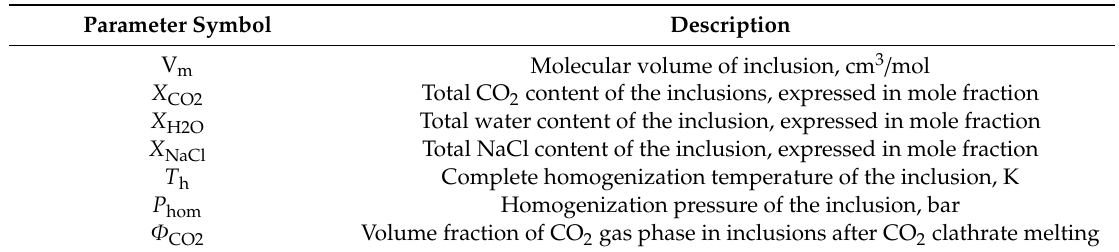
Table 2. Output parameters of the program for H 2 O–NaCl–CO 2